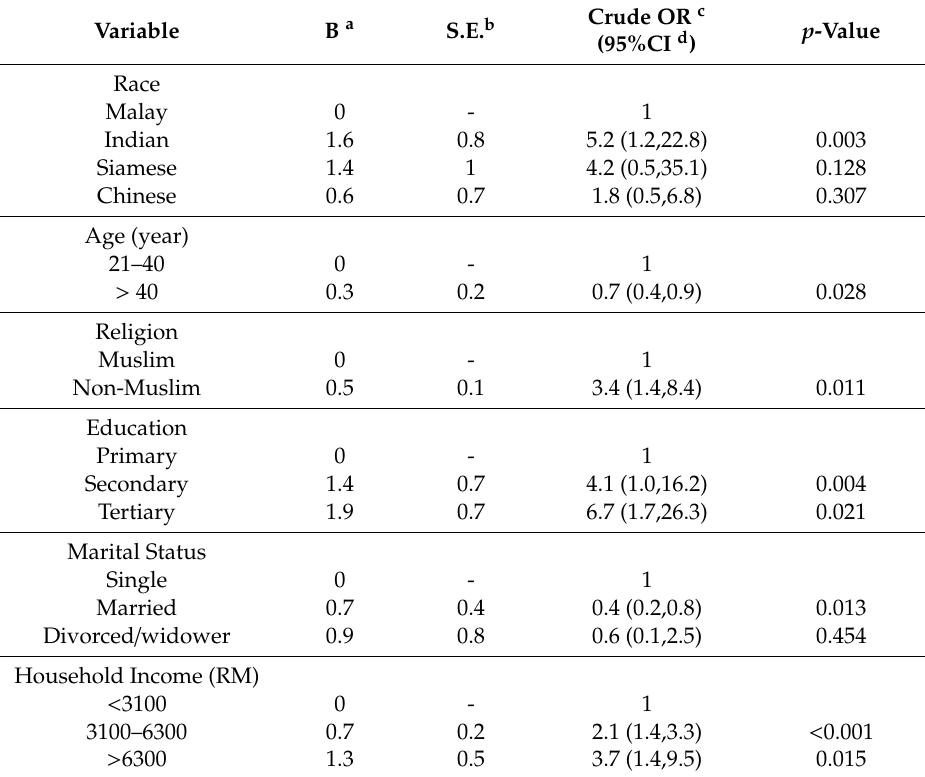
Table 2. Association between sociodemographic characteristics with inappropriate TSB, using simple logistic regression analysis ( n =